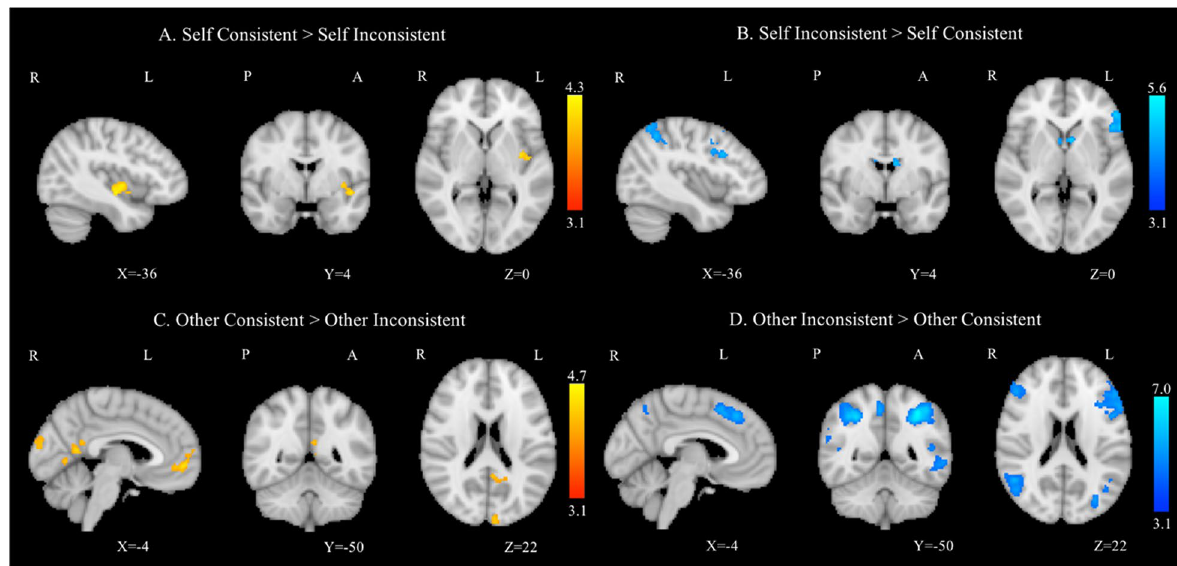
Figure 3. Group average task-related GLM analysis for the contrast Self Consistent > Self Inconsistent ( A ) and for the inverse comparison Self Inconsistent > Self Consistent ( B ), and for the contrasts Other Consistent > Other Inconsistent ( C ) and Other Inconsistent > Other Consistent ( D ). Right hemisphere on the left and side, all clusters were thresholded by Z > 3.1 and a corrected cluster significance threshold of p = 0.05.